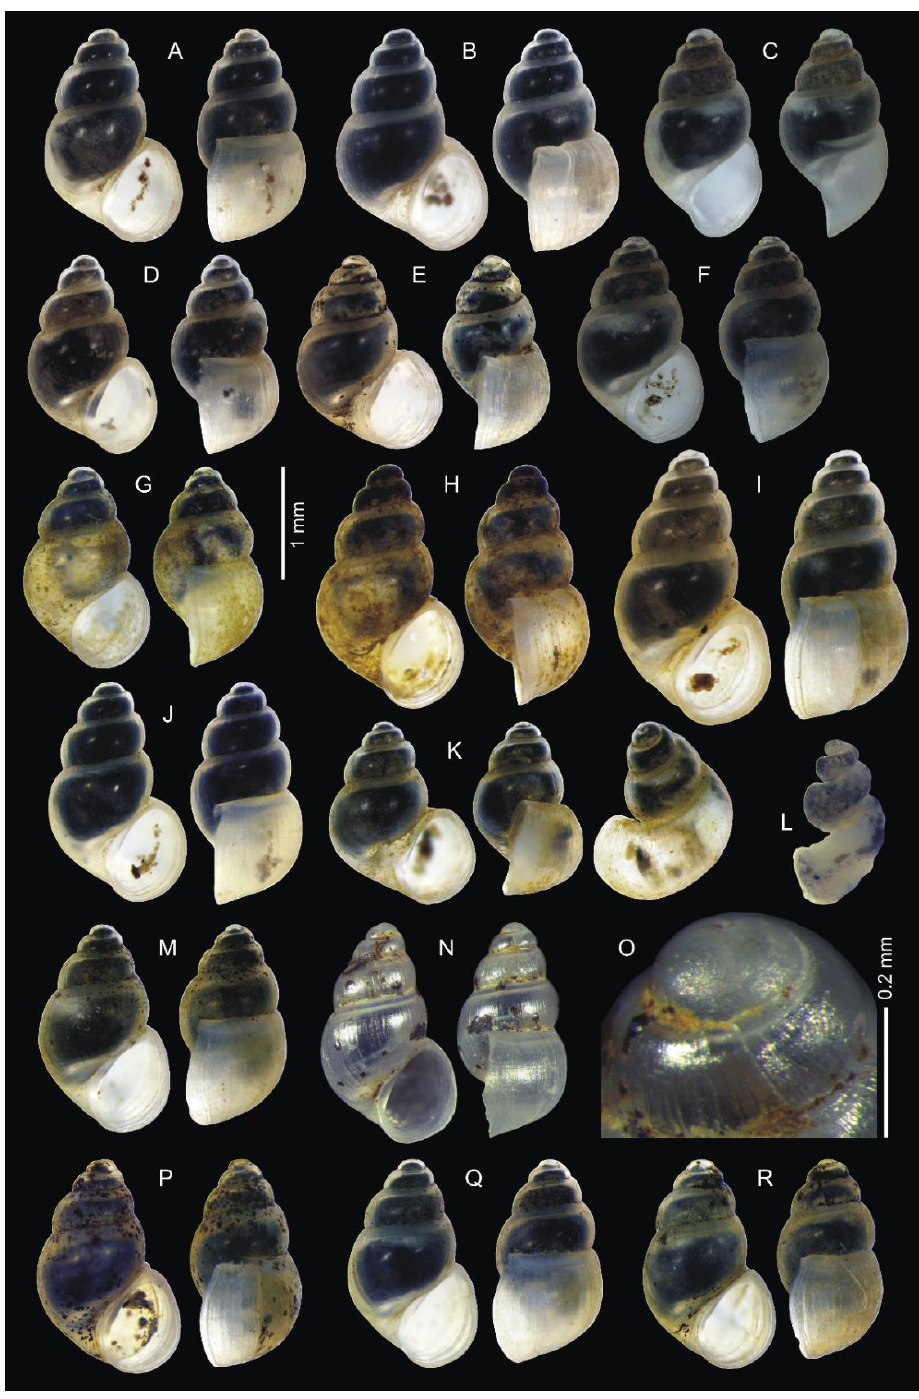
Figure 4. Clathrocaspia laevigata sp. n.: ( A ) — holotype, ZIN 541-2021/1; ( B ) — paratype, IZAN 612/a; ( C ) — paratype, IZAN 613/b; ( D ) — paratype, IZAN 612/c; ( E ) — paratype, IZAN 613/a; ( F ) — paratype, IZAN 613/c; ( G ) — specimen IZAN 610/2; ( H ) — specimen IZAN 610/3; ( I ) — paratype, IZAN 612/1 (the same individual as Figure 7A,D,G,J); ( J ) — specimen IZAN 612/4; ( K ) — specimen IZAN 612/2 (the same individual as Figure 9A,D,E); ( L ) — specimen IZAN 610/1, soft body; ( M ) — paratype, IZAN 613/3, loc. Dag32 (the same individual as Figure 7B,H,K,L); ( N , O ) — specimen IZAN 608/1 ( N ) — shell after treatment with bleach; (O) — the protoconch enlarged), a fine sculpture is visible in O; ( P ) — specimen IZAN 613/2; ( Q ) — specimen IZAN 613/1 (the same individual as Figure 9B); ( R ) — specimen IZAN 613/4. ( A , B , D , I – K ) — from the locality Dag28; ( C , E , F , M , P – R ) — from the locality Dag32; ( G , H , L ) — from the locality Dag23; ( N , O ) — from the locality Dag12.